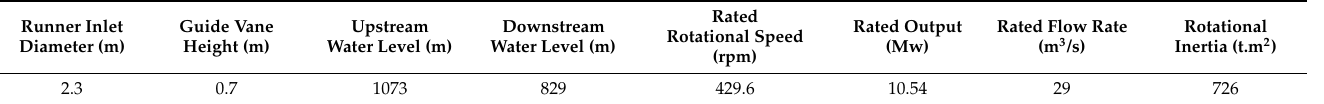
Figure 6. Schematic of the hydropower station with a sand basin.